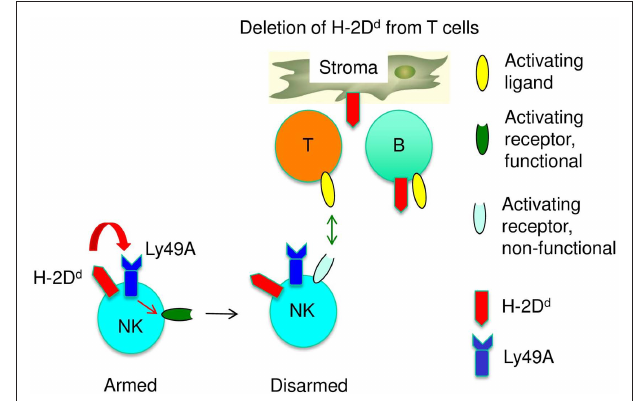
FIgure 2 | A sequential arming/disarming model for the adaptation of immature NK cells to self-MHC class I is shown. The co-expression of Ly49A and H-2Dd by NK cells, and thus their interaction in cis , renders NK cell activation receptors functional (arming). The absence of H-2Dd from other cells in trans (e.g., T cells) results in chronic NK cell stimulation by T cells, which will eventually disarm activation